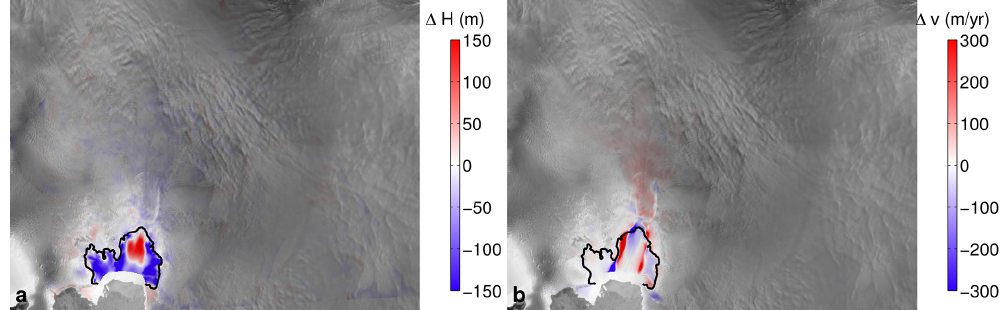
Figure 4. (a) Thickness change (in m) and (b) velocity change (in myr − 1 ) during the 10yr relaxation period overlain on a MODIS Mosaic of Antarctica. Black line represents the grounding